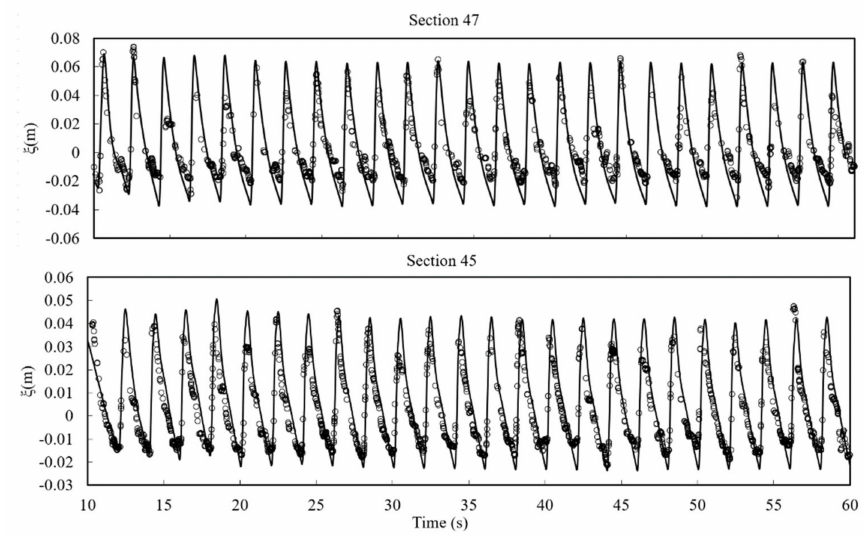
Figure 8. Comparison of simulated and measured free surface elevations for case T1 (spilling wave)